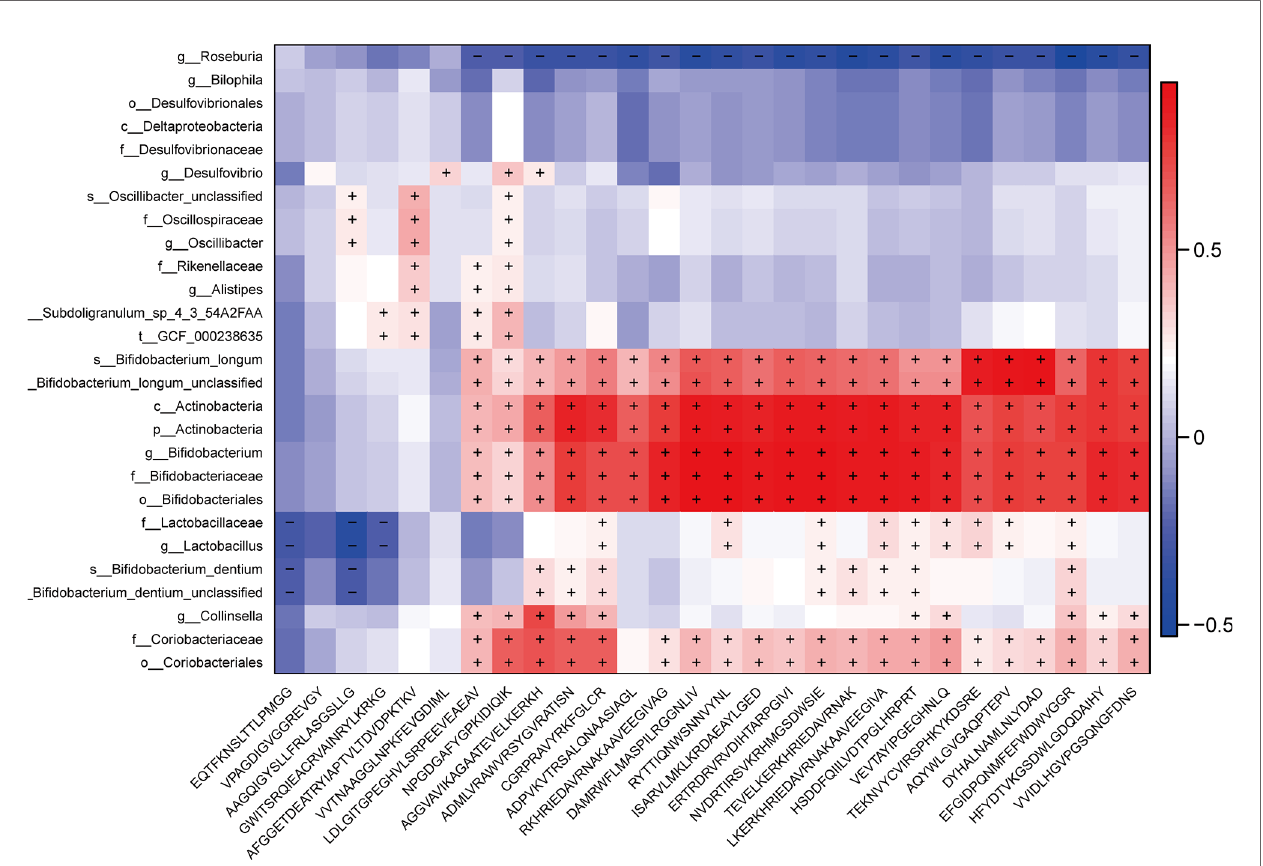
FIGURE 5 | Correlations between 27 potential bacterial biomarkers and 28 selected epitope biomarkers. The Spearman correlation was calculated and tested using the “ cor.test ” function. The right panel shows the size of the correlation coef fi cient, with: red representing a positive correlation; blue representing a negative correlation; and “ + ” and “ − ” in each lattice representing signi fi cant positive and negative correlations (P < 0.05),